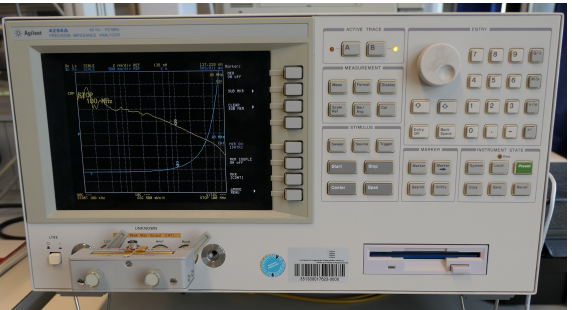
Figure 8. Impedance analyzer Agilent 4294A with the attached ISIT sample.